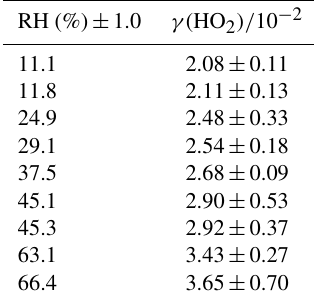
Table 1. Reactive HO 2 uptake coefficients, γ (HO 2 ), for TiO 2 par- ticles at different